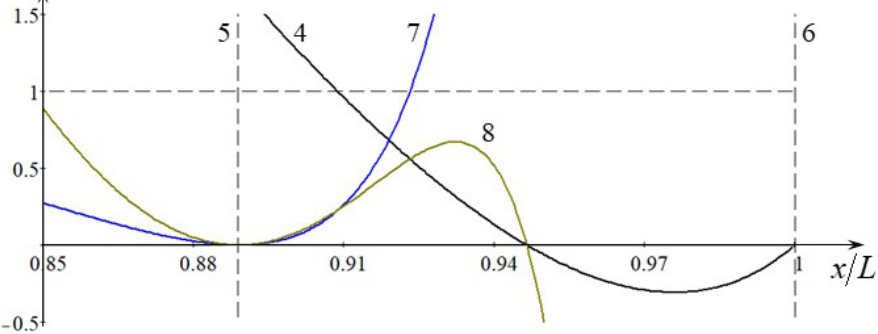
Figure 2. (Color online) A fragment of Frame (c) in Figure 1. Normalised coefficients of NLS Equation (7): line 4—50 p ( x ) / p ( 0 ) ; line 7— q ( x ) / q ( 0 ) ; line 8—50 p ( x ) q ( x ) / p ( 0 ) q ( 0 ) ; lines 5 and